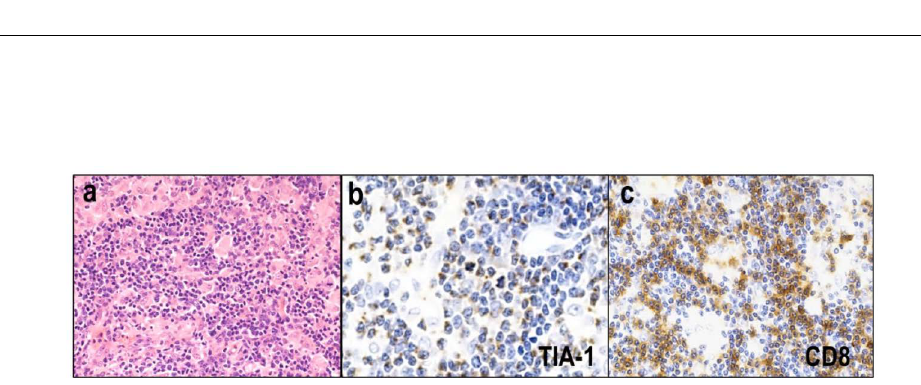
Figure 10. Lymphoepithelioid variant of peripheral T-cell lymphoma, NOS (Lennert lymphoma). ( a ) Numerous clusters of epithelioid histiocytes, and the infiltration of small-to-medium-sized lym- phocytes with slight nuclear irregularities (HE 400). ( b , c ) Tumor cells are usually positive for × cytotoxic molecule (TIA-1 400) and (CD8 × ×